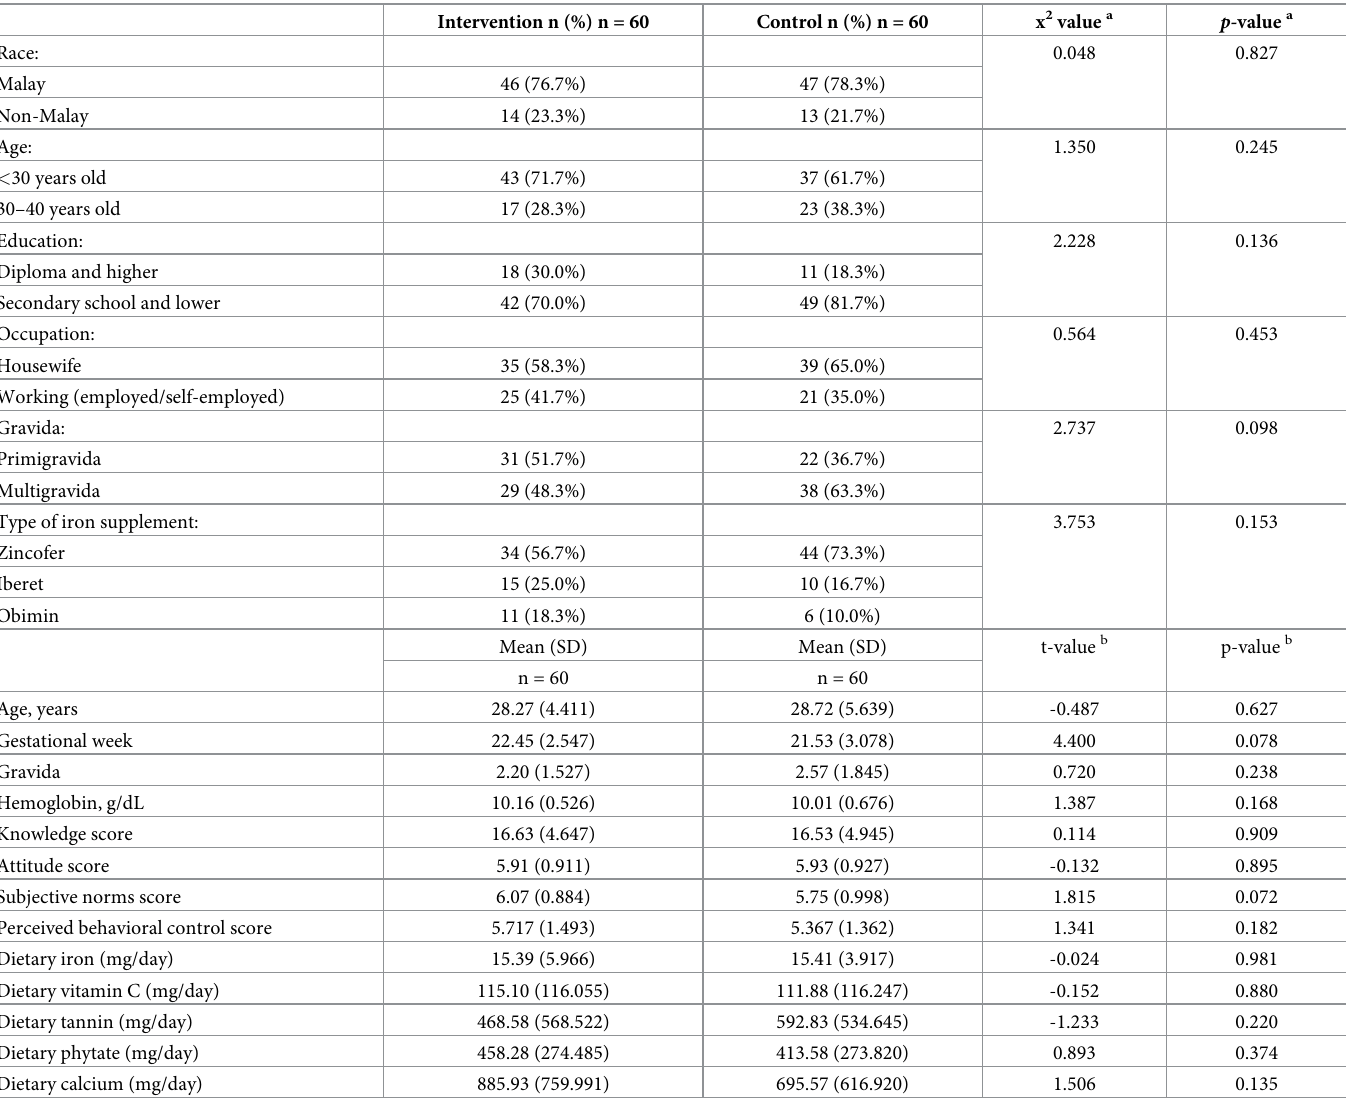
Table 3. Comparison of participants’ characteristics in intervention and control groups at baseline.